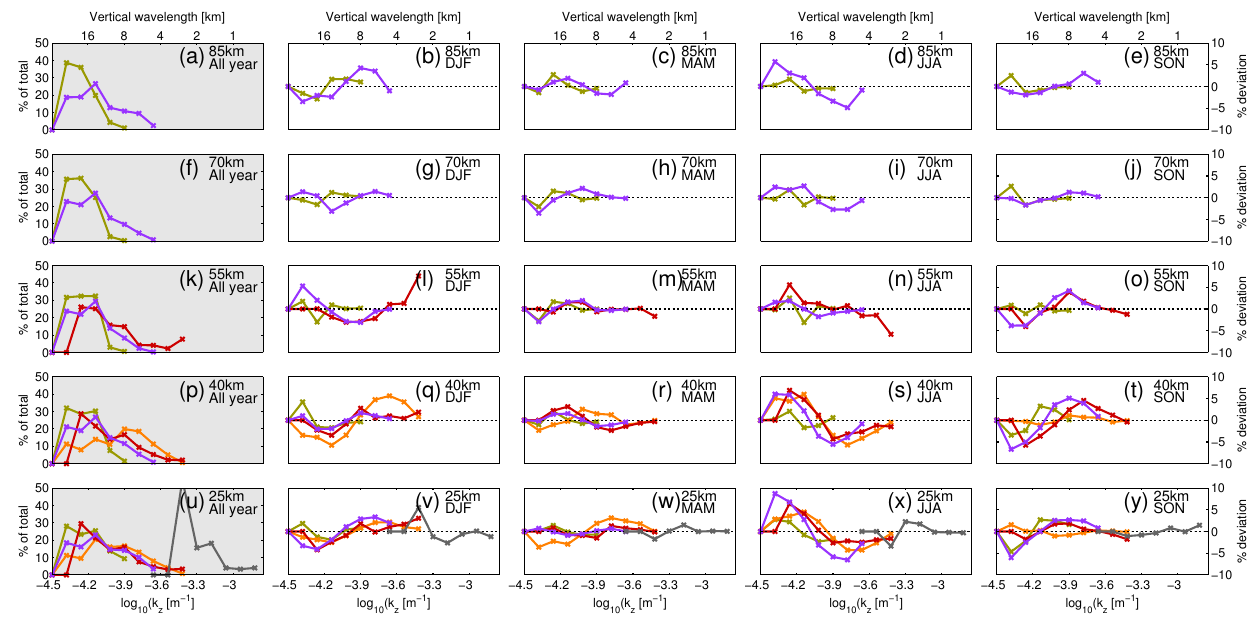
Figure 19. Histograms of observed vertical wavelengths for all limb-sounding instruments at all levels. The leftmost column (a, f, k, p, u) shows histograms of all data considered, normalised to sum to 100%. Remaining panels show differences between the normalised distribution for each season and the annual mean normalised distribution at that high level, as a percentage difference. Top and bottom axes are